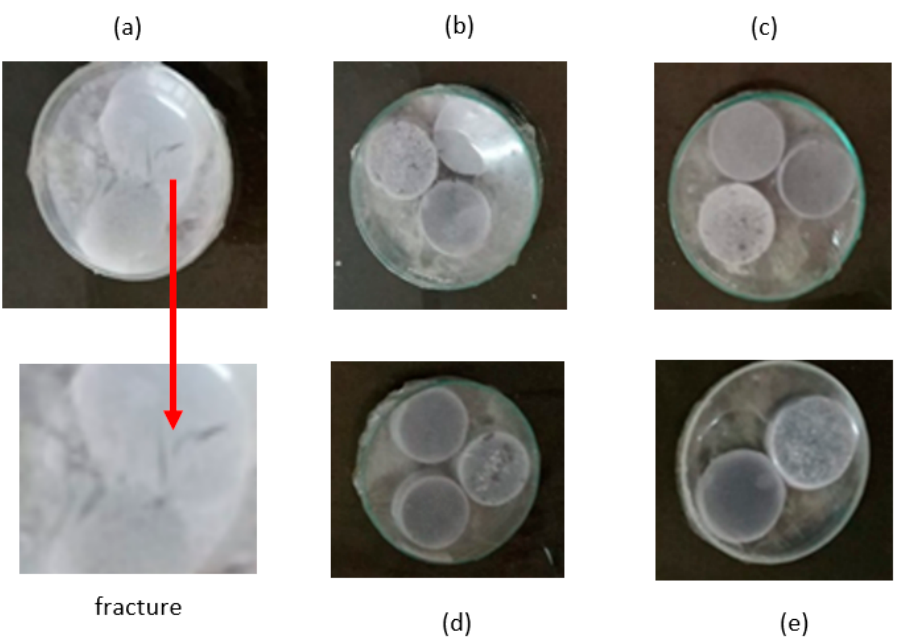
Figure 6. Visual observation of Alginate/PVA/r-GO at the fifth week with 0 wt.% r-GO ( a ), 0.4 wt.% r-GO ( b ), 0.8 wt.% r-GO ( c ), 1.2 wt.% r-GO ( d ), and 1.6 wt.% r-GO ( e ). The arrow shows the zoom in of the fracture